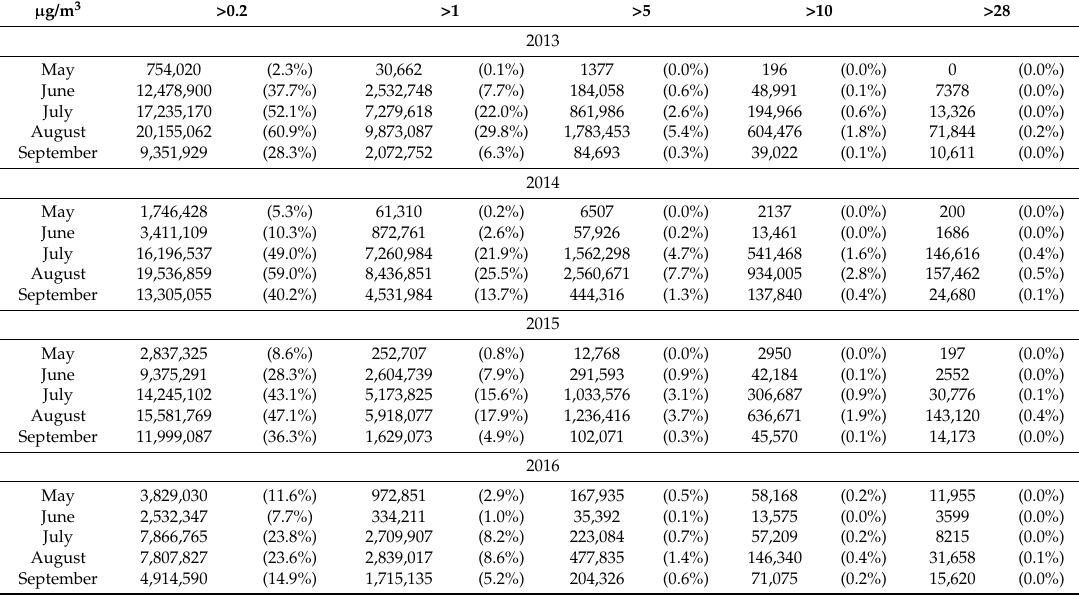
Table 2. FireWork domain area affected (km 2 and percentages) by wildfire pollution above five PM 2.5 concentration thresholds based on average monthly and seasonal fire-PM 2.5 contributions to total average monthly and seasonal surface PM 2.5 concentrations. For reference, the total area of North America is 24.71 million km 2 and for the FireWork domain is 33.09 million km 2 . The numbers in parentheses correspond to the percentage of the area